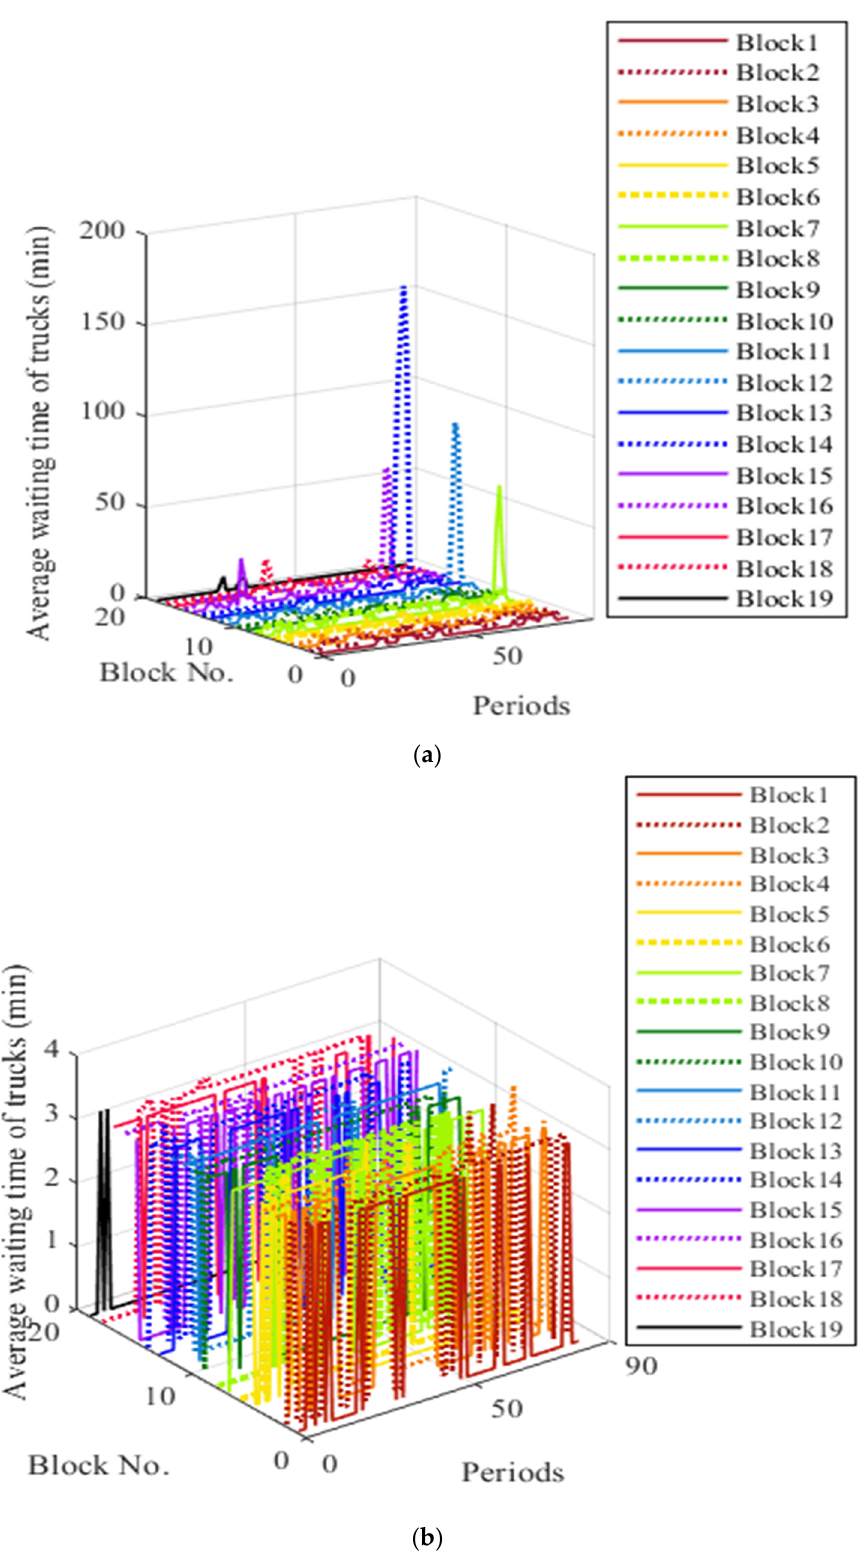
Figure 10. The truck waiting time at each yard block before and after VDTWs optimization: ( a ) Before VDTWs optimization; ( b ) After VDTWs optimization.